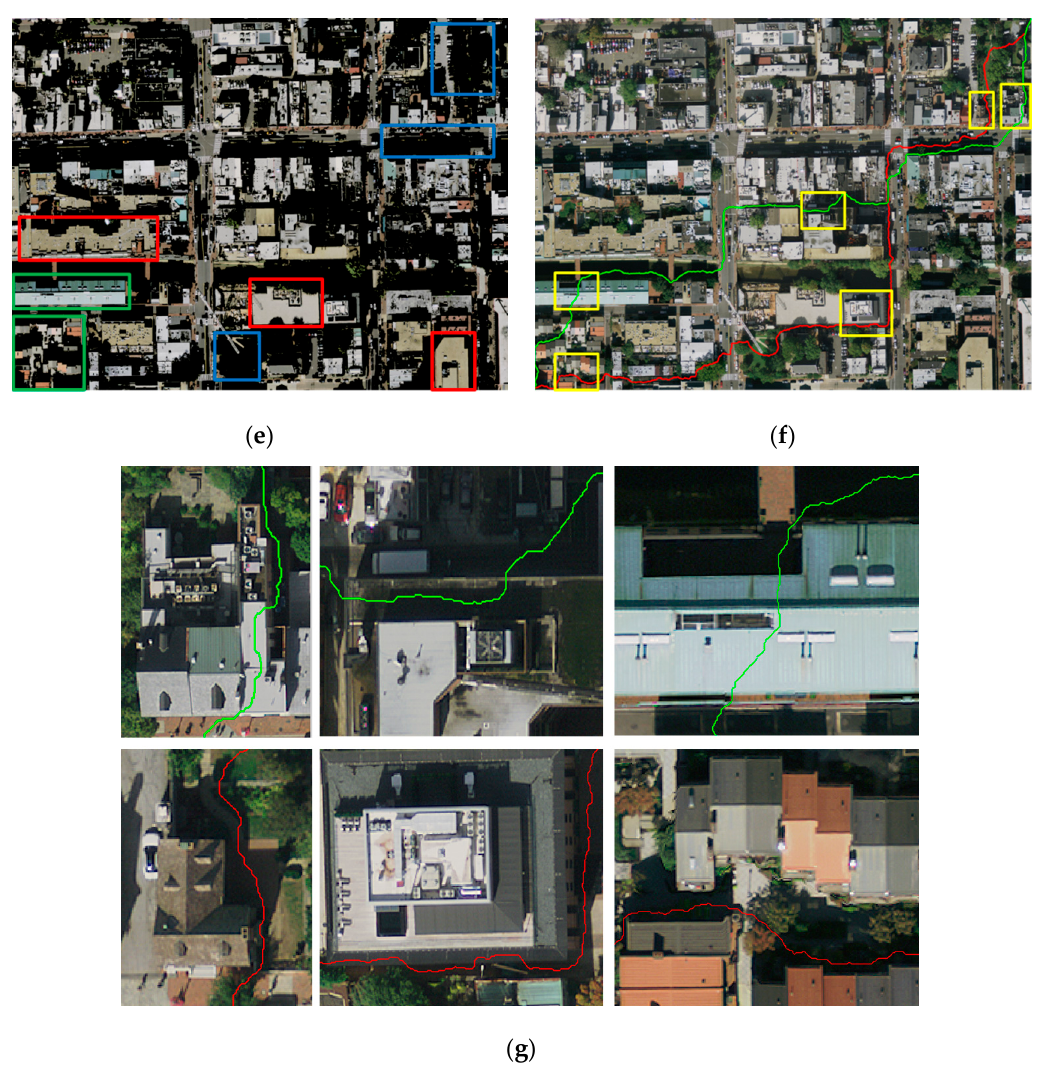
Figure 7. Experimental results of image set 1: ( a ) the left image; ( b ) the right image; ( c ) mean-shift segmentation result ( T S = 50); ( d ) mean-shift segmentation result ( T S = 80); ( e ) PKGC segmentation result; ( f ) seamlines by Pan’s method (green line) and ours (red line); ( g ) details marked rectangles in ( f ).